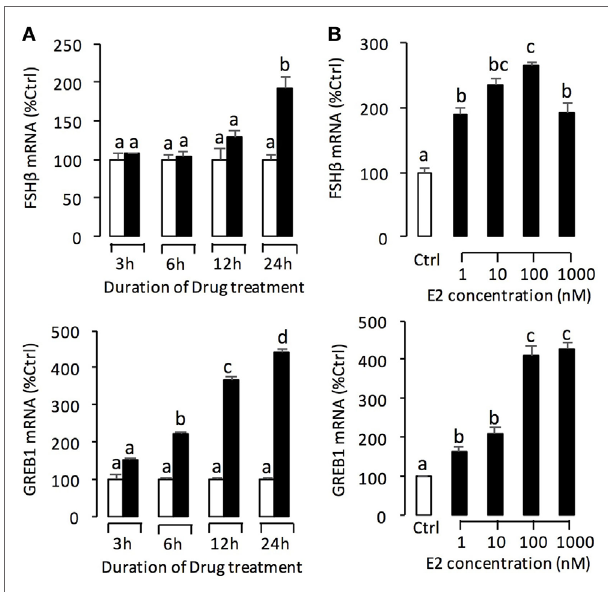
FigUre 3 | E2 induce follicle-stimulating hormone (FSH) β and growth regulation by estrogen in breast cancer 1 (GREB1) mRNA expression in grass carp pituitary cells. (a) In the time-course experiment, pituitary cells were incubated with E2 (100 nM) for the duration as indicated. (B) In parallel studies for dose dependence, pituitary cells were challenged for 24 h with increasing levels of E2 (1–1,000 nM). After drug treatment, the remaining cells were used for total RNA preparation for real-time PCR of the FSH β and GREB1 mRNA expression. Data presented are expressed as mean ± SEM, and groups denoted by different letters represent a significant difference at P < 0.05 (ANOVA followed by a Dunnett’s